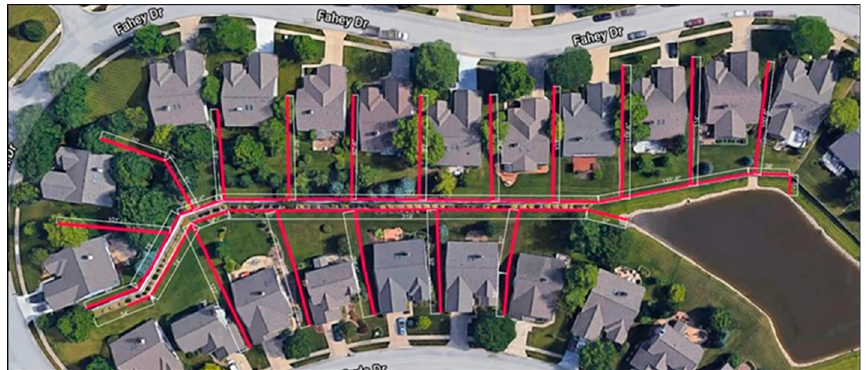
Figure A1. Drainage layout for French drain. Table A1. The construction work and duration of the alternatives for retaining wall rehabilitation.